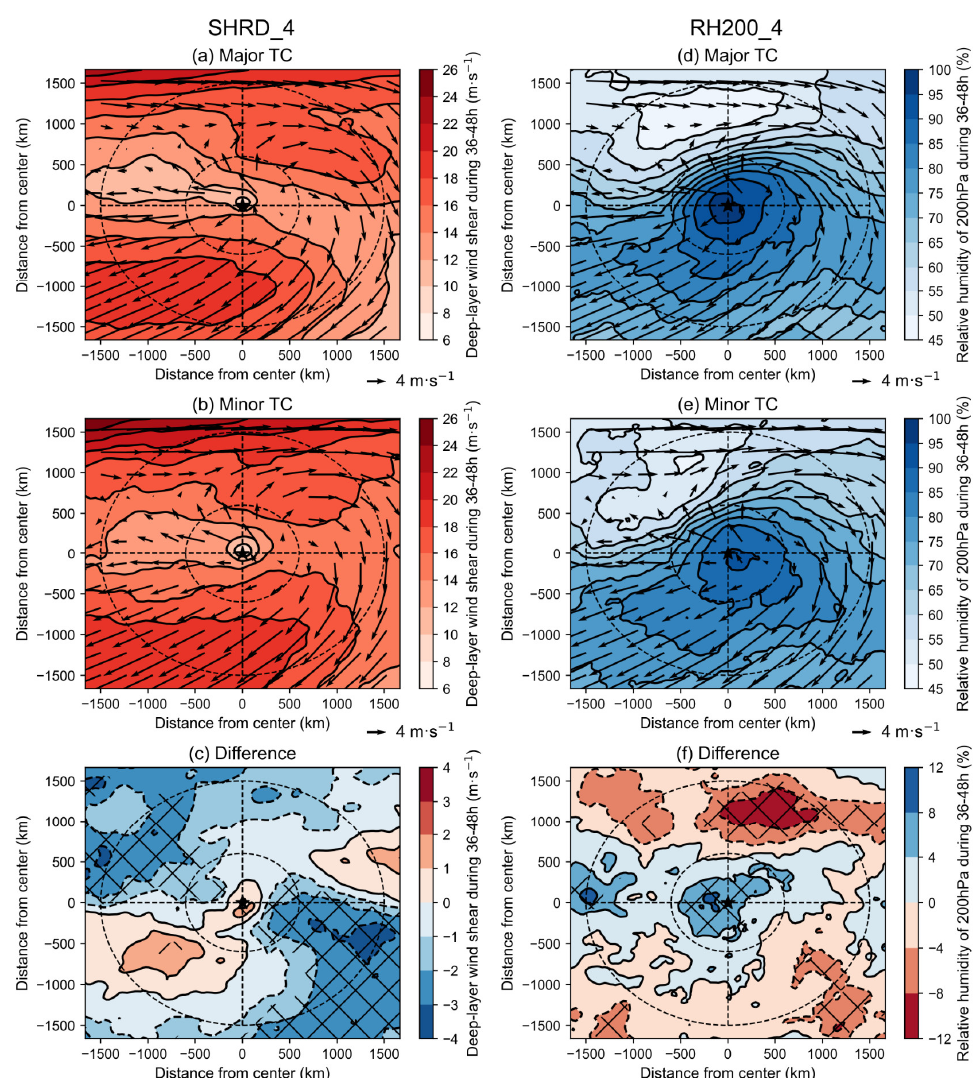
Figure 12. Storm-centered composites of ( a ) deep-layer vertical wind shear of 850-200 hPa during first 36–48 h after genesis (SHRD_4) by contours with wind vectors at 200 hPa (10 − 5 m s − 1 ) and ( d ) relative humidity at 200 hPa during first 36–48 h after genesis (RH200_4) by contours with wind vectors at 200 hPa (%) for major TCs. ( b , e ) Same as ( a , d ), but for minor TC. ( c , f ) Differences in major minus minor TCs. Black star represents storm center and dotted black lines are boundaries of eight sectors discussed in Figure 1. Areas with crossing lines in ( c ) and ( f ) depict where differences between the two categories are statistically significant at the 95% confidence level.